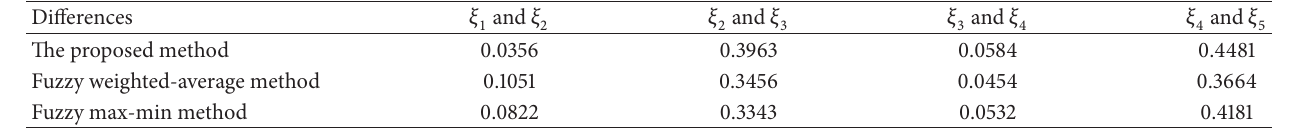
Table 6: The differences between two adjacent